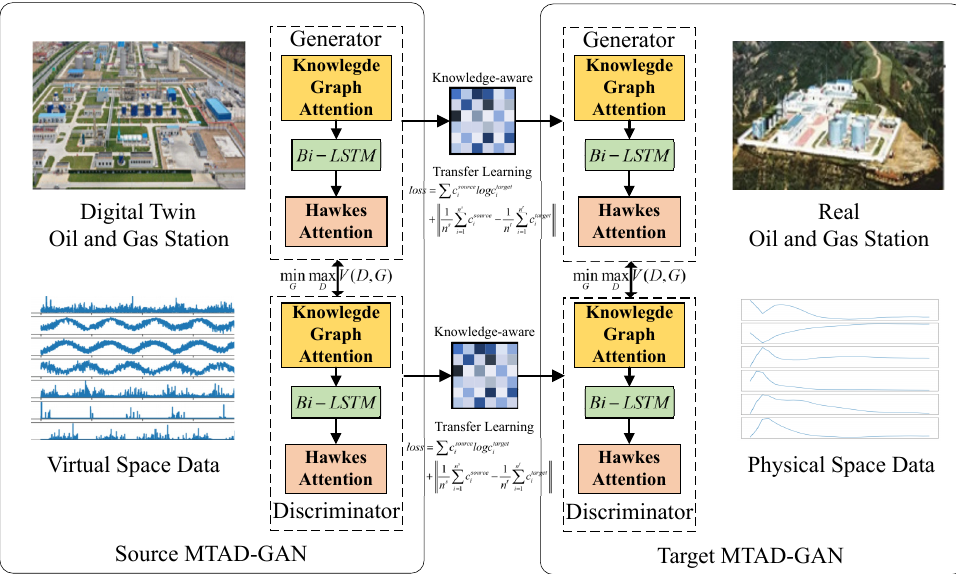
Figure 5. Knowledge-aware transfer learning Network